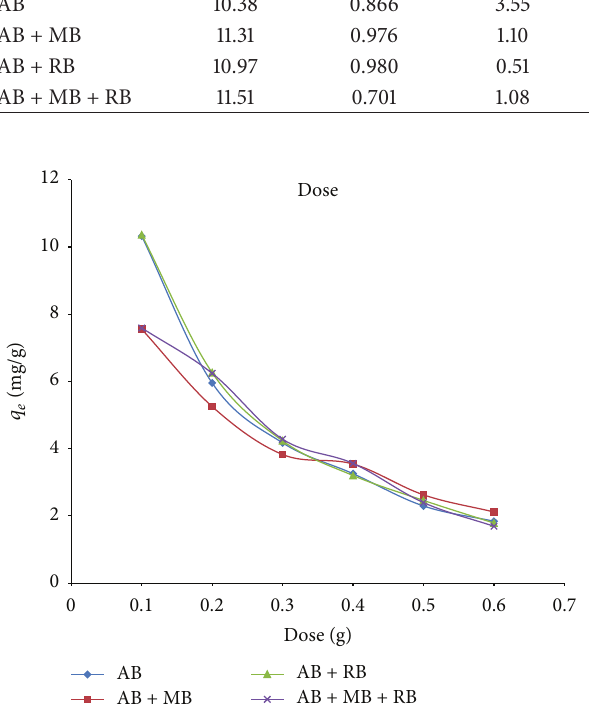
Figure 4: Effects of RSD dose on adsorption of Acid Blue 161 on raw sawdust.